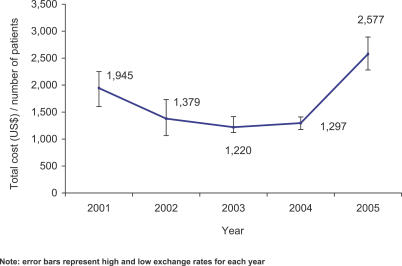
Ratio of Total Annual ARV Costs in US Dollars to Numbers of Patients on Treatment